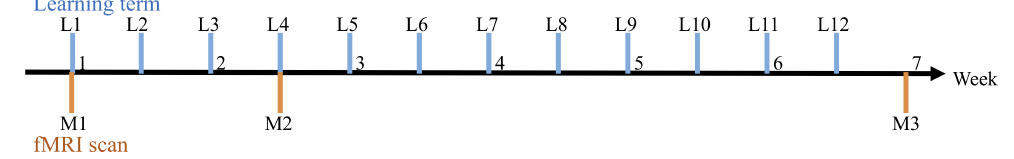
Figure 5. Experimental flow over 7